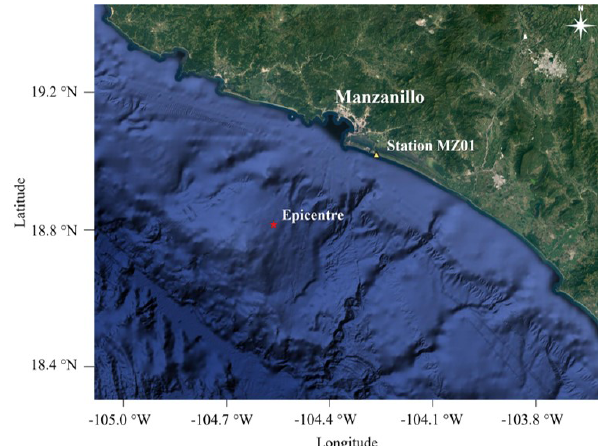
Figure 7. Location of the seismic station MZ01 and the epicentre of the 1995 Manzanillo earthquake ( M w = 8) event (© Google